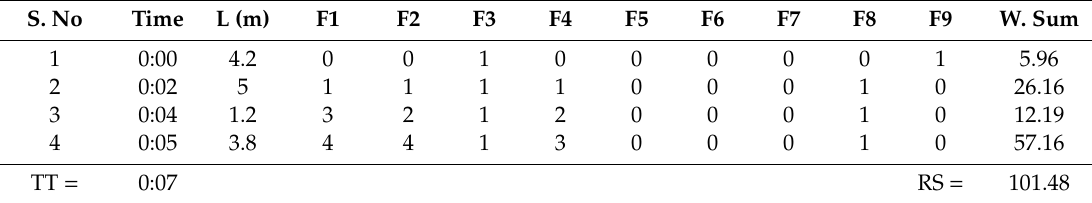
Table 5. RS calculation for Route 1.